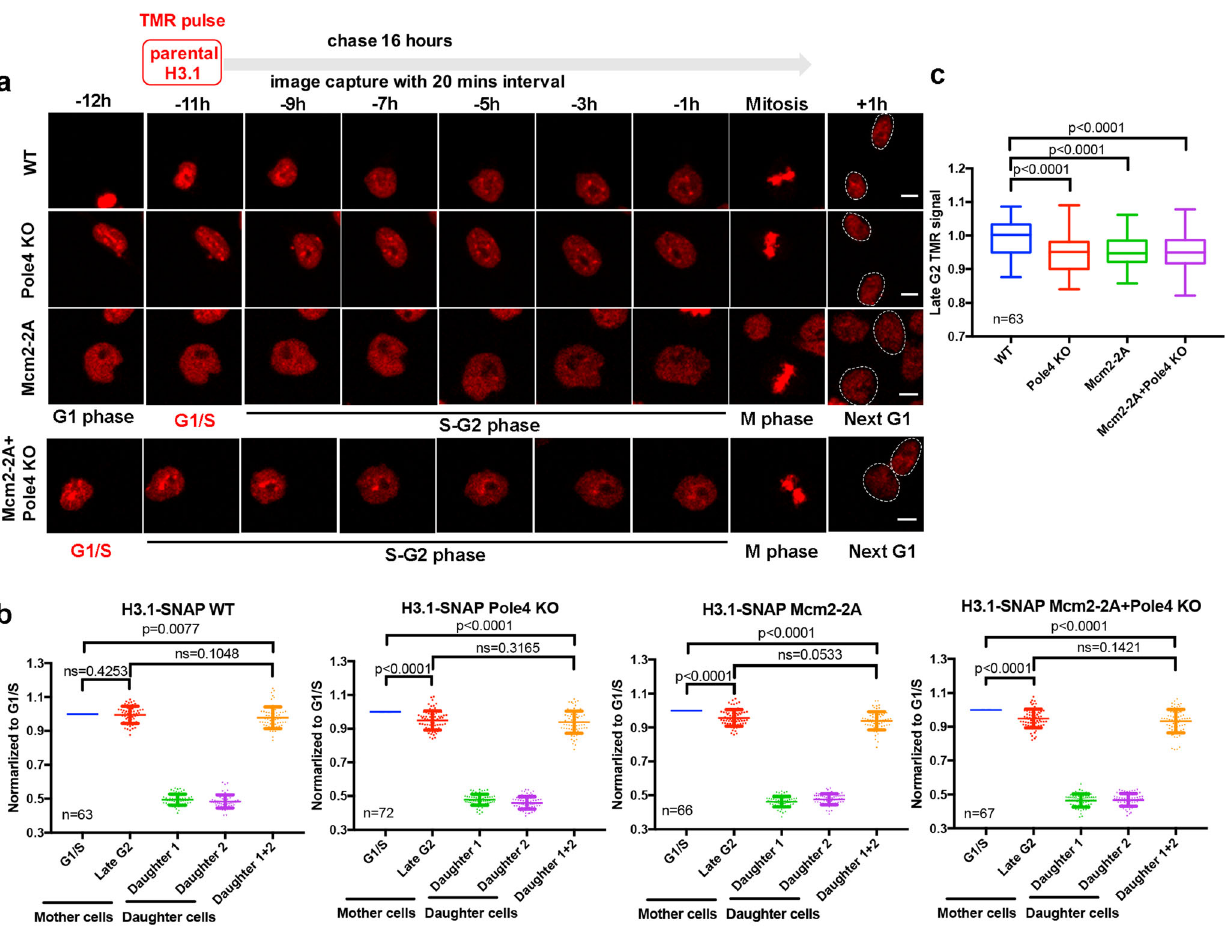
Fig. 2 Histone chaperones Mcm2 and Pole4 are involved in the recycling of parental H3.1. a Upper: an experimental scheme for the analysis of H3.1- SNAP in mES cells using live-cell imaging. Lower: representative live-cell images of TMR of parental histone H3.1-SNAP at the indicated time points in WT ( n = 63), Pole4 KO ( n = 72), Mcm2-2A ( n = 66) and Pole4 KO + Mcm2-2A double mutant ( n = 67) mES cells. Scale bar, 10 µ m. Two daughter cells arising from the mother cell were circled. b Quanti fi cation of parental H3.1-SNAP signals WT, Pole4 KO, Mcm2-2A and Mcm2-2A + Pole4 KO mES cells at G1/S and G2 of each mother cell and G1 of the two individual daughter cells. Data are presented as means± SD. c Boxplot of relative parental H3.1-SNAP signals at G2 calculated in ( b ) among WT, Pole4 KO, Mcm2-2A and Mcm2-2A + Pole4 KO mES cell lines. The center line is the medians of all data points, with the limits corresponding to the upper and the lower quartiles, respectively, and the whiskers representing the largest and smallest values. a – c n number of cells from two independent experiments. b , c Statistical analysis was performed by two-tailed unpaired Student t test with P values shown on the graphs. ns no signi fi cant difference.